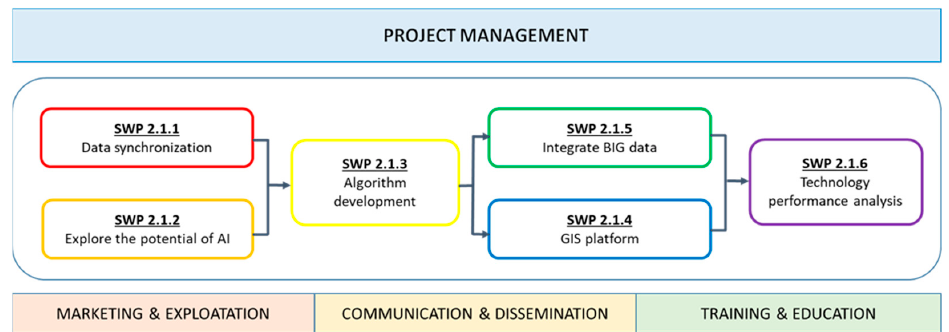
Figure 7. Work logic diagram of Work Package 2.2, NRP-SCP.